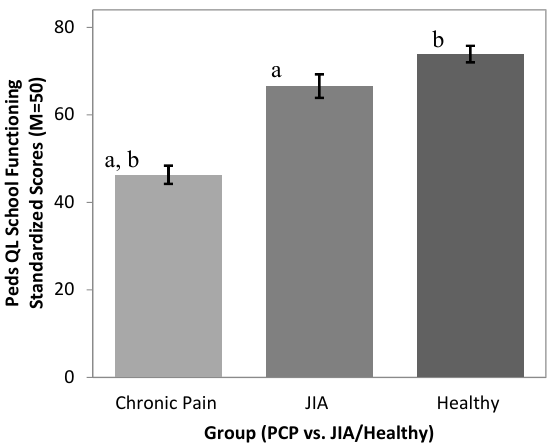
Figure 1. Pediatric Quality of Life inventory (Peds-QL) school function scores in Chronic Pain (PCP), juvenile idiopathic arthritis (JIA) and Healthy groups. Groups marked “a” differ from one another at p < 0.001; Groups marked “b” differ from one another at p <